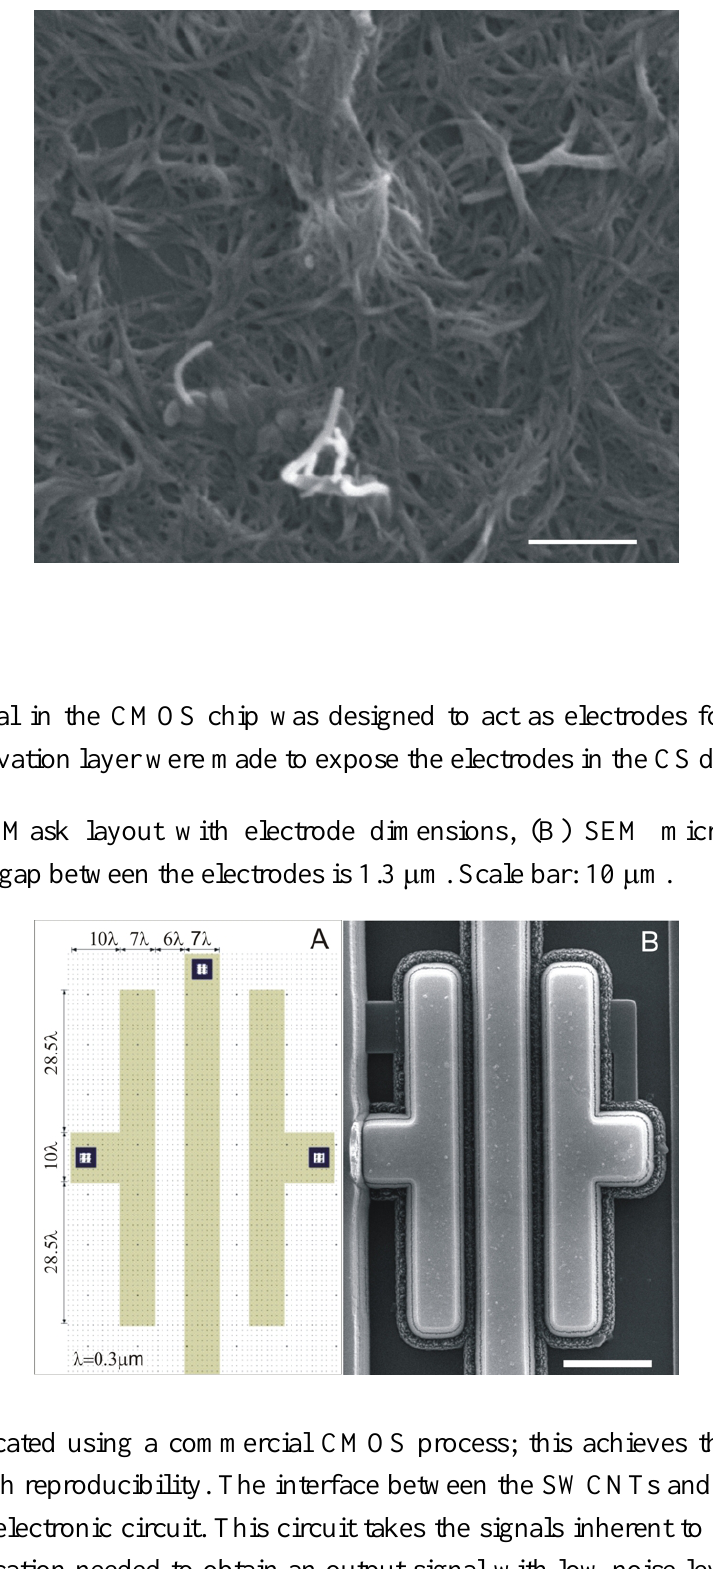
Figure 1. SEM micrography of SWCNTs. Scale bar: 100 nm.